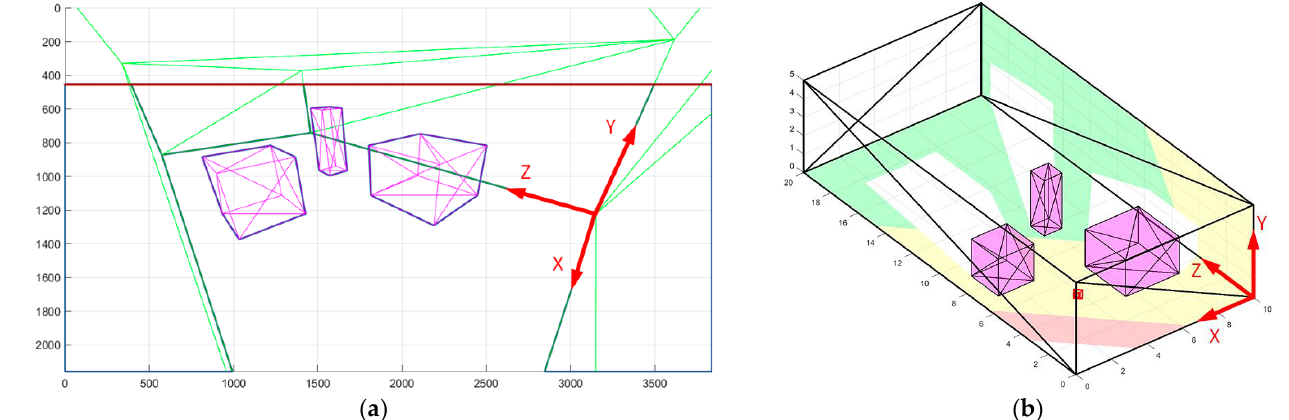
Figure 3. Visual sensor modeling: ( a ) camera view horizon (red); and ( b ) dead zones caused by obstacles (white).